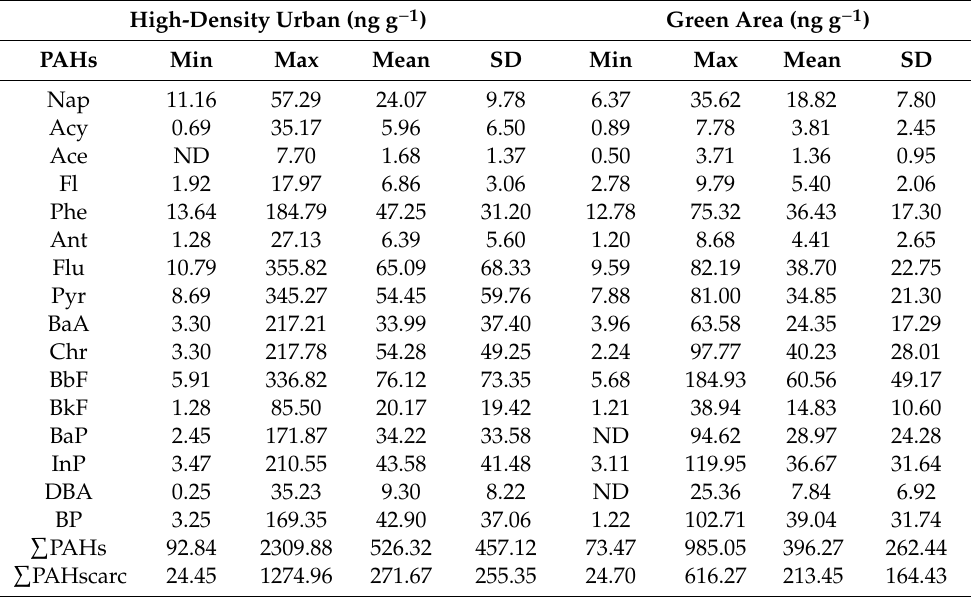
Table 4. The Statistical characteristics of